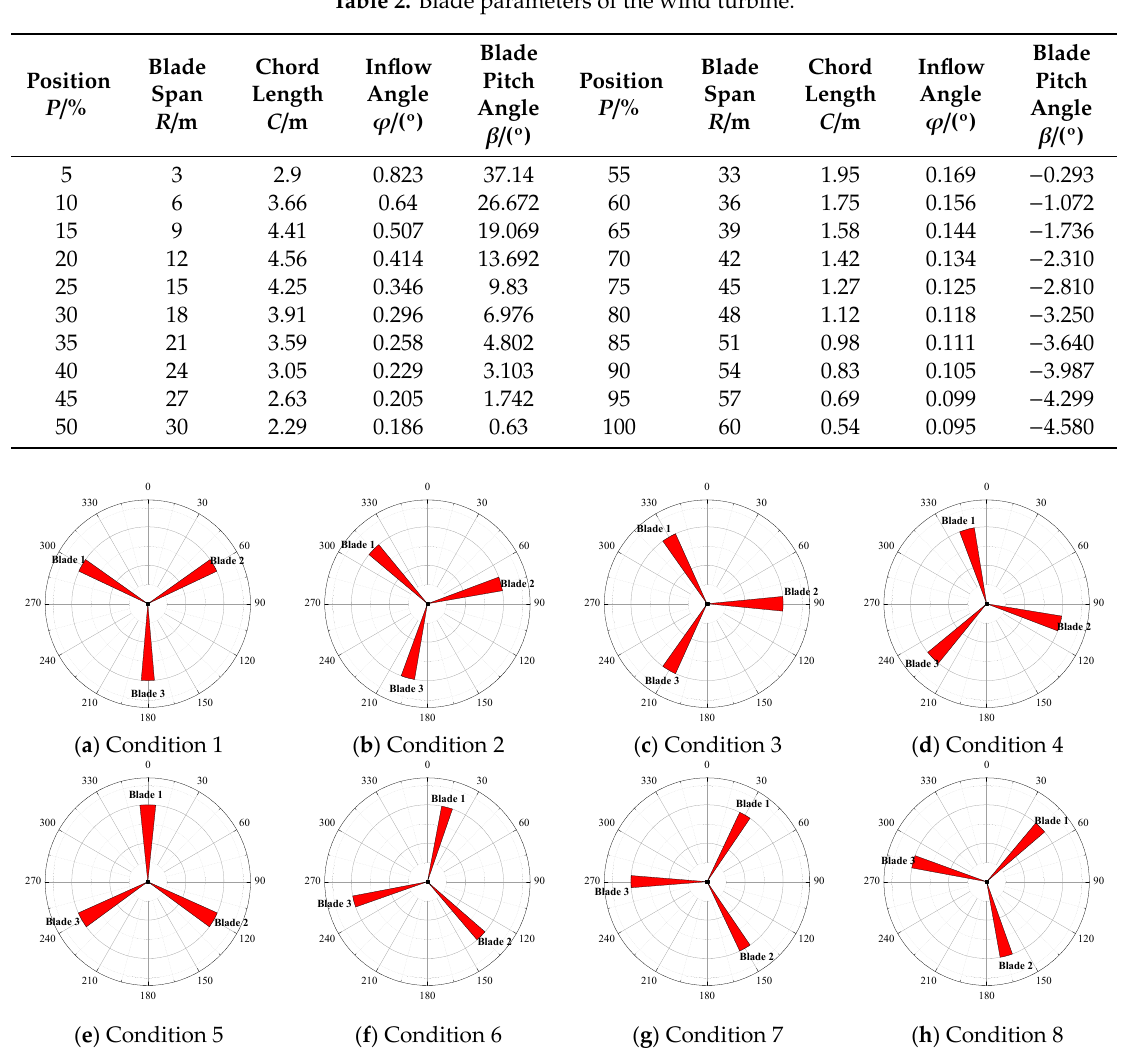
Table 2. Blade parameters of the wind turbine.